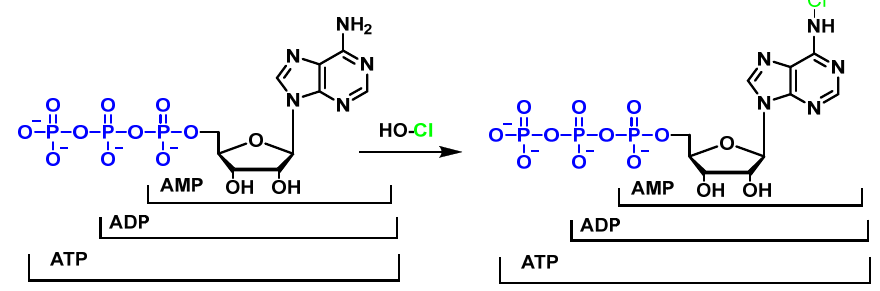
Figure 42. Intra- or intermolecular hydrogen abstraction reactions.